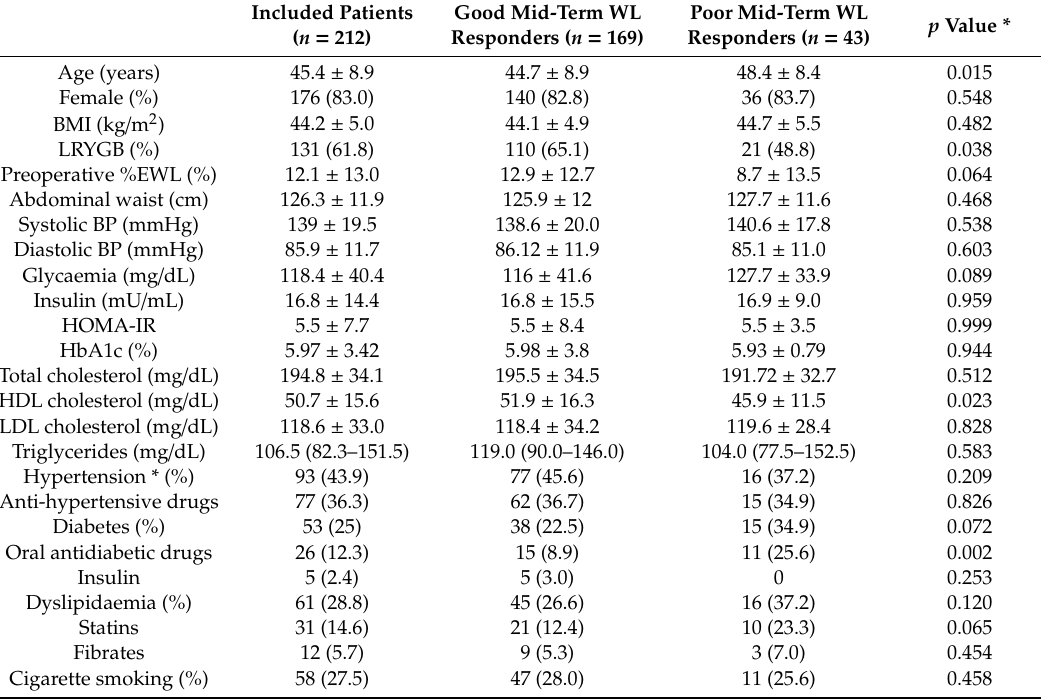
Table1. Baselinecharacteristicsofallincludedpatients, goodandpoormid-termweightlossresponders. Included Patients ( n = 212)